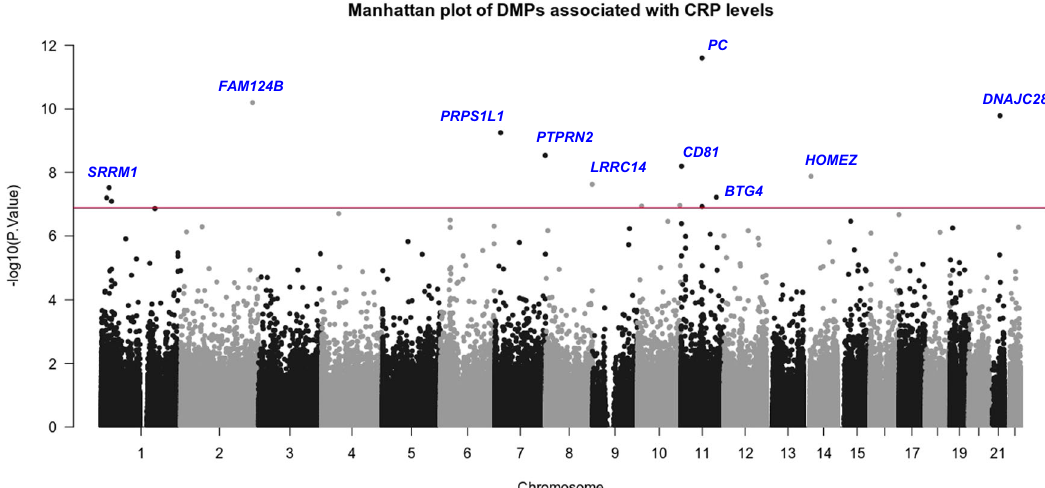
Fig. 1 Manhattan plot of DMPs associated with CRP among Ghanaians. All 429,459 CpG sites are presented according to p -value in EWAS, as well as by chromosomal annotation. Red line is the demarcation line for statistically signi fi cant DMPs at p < 1.1E-7.